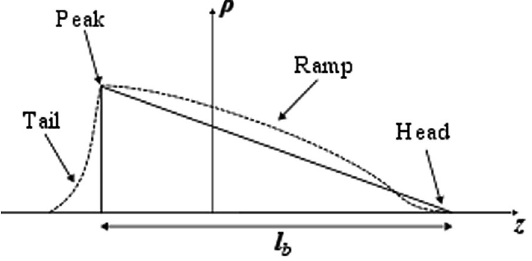
FIG. 6. The four key characteristics of the triangular